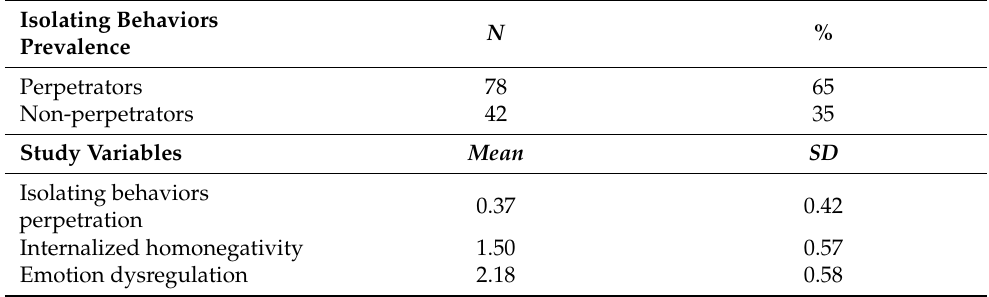
Table 2. Frequencies and mean scores of scales for study variables.